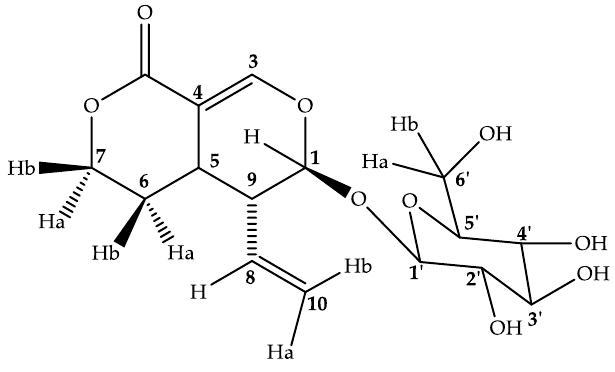
Figure 3. Structure of compound 1 .